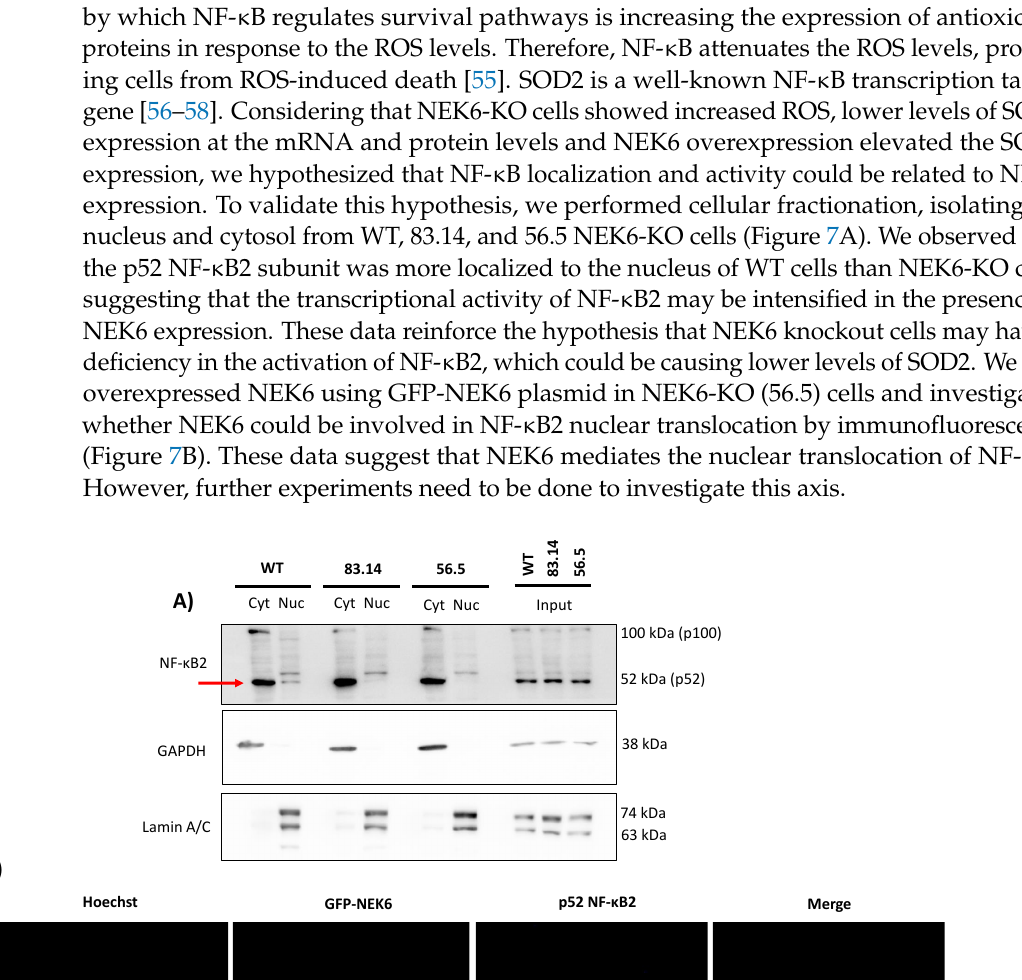
Figure 7. NEK6 is involved in the nuclear translocation of NF- κ B2. ( A ) Nuclear (Nuc) and cytoplasmic (Cyt) fractions were obtained from WT and NEK6-KO (83.14 and 56.5) cells. GAPDH and Lamin A/C were used as the cytoplasmic and nuclear control, respectively. ( B ) NEK6-KO (56.5) cells were transfected with GFP-NEK6, and an immunofluorescence assay was performed to stain NF- κ B2 in red. Hoechst 33342 was used for staining the